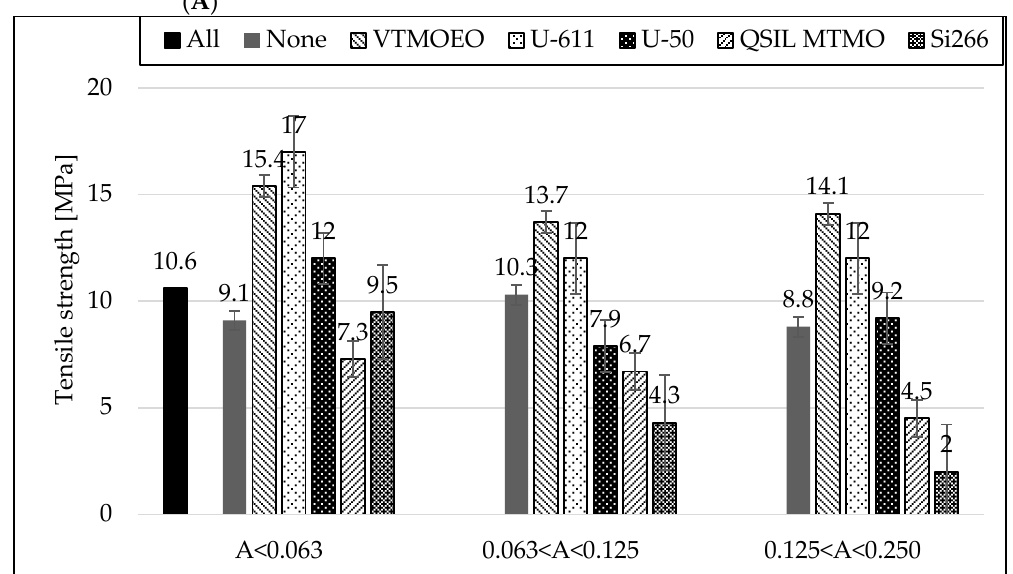
Figure 9. Influence of the silanization of fly ash with various silanes on mechanical properties: TS ( A ) and elongation at break ( B ) of the rubber vulcanizates filled with CB and different FA